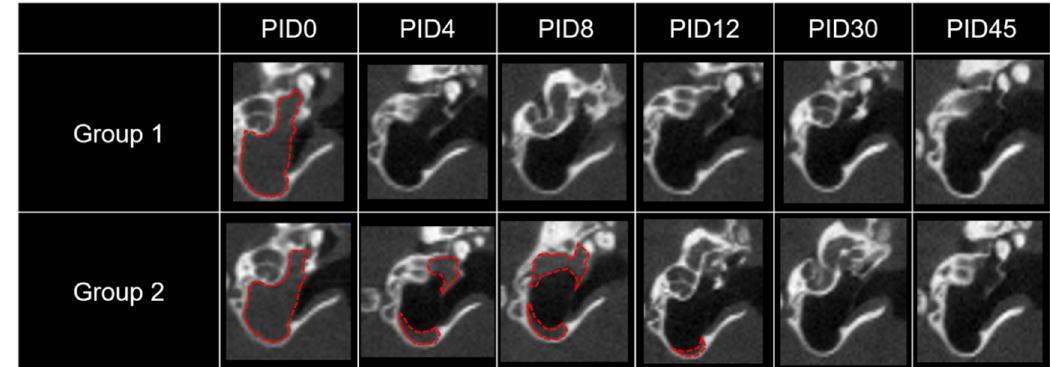
Figure 1. Micro CT of the drug/vehicle in the middle ear. Signal attenuation (indicated by red dotted lines) in the middle ear indicates the mixture of drugs and vehicle. Based on micro CT evaluation from PID0 to 45, the drug/vehicle lasted in the middle ear for less than 1 day in group 1 and for 8 to 12 days in group 2.